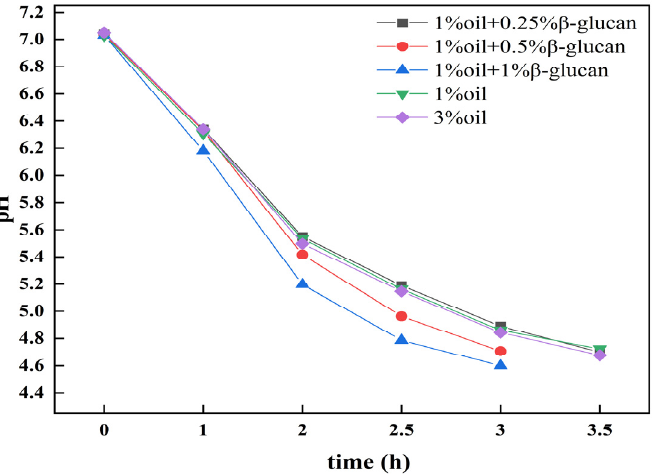
Figure 1. The pH changes of low-fat pea-protein-based yogurt during the fermentation process as a ff ected by oat β -glucan concentration.